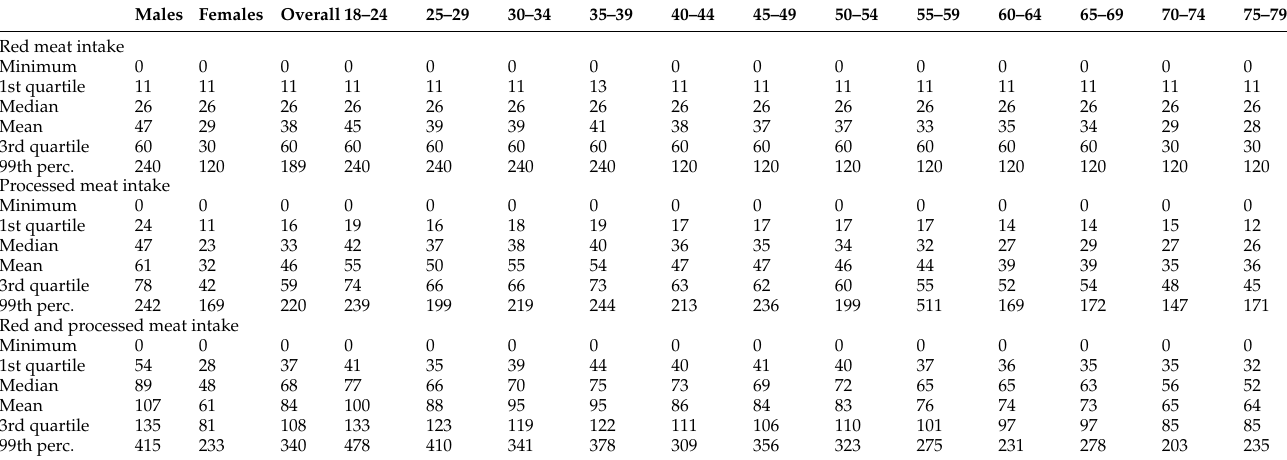
Table 1. Summary statistics of red and processed meat intake (grams/day) in Germany according to the DEGS1 survey among 8152 adults aged 18 to 79 conducted between 2008 and 2011, overall, by sex, and by 5-year age categories.